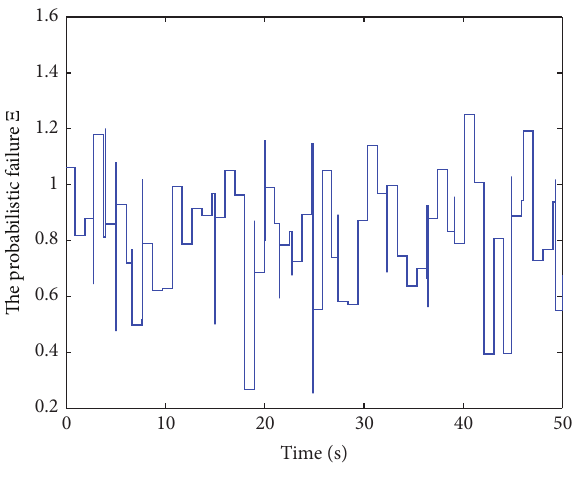
Figure 3: The probabilistic failure Ξ